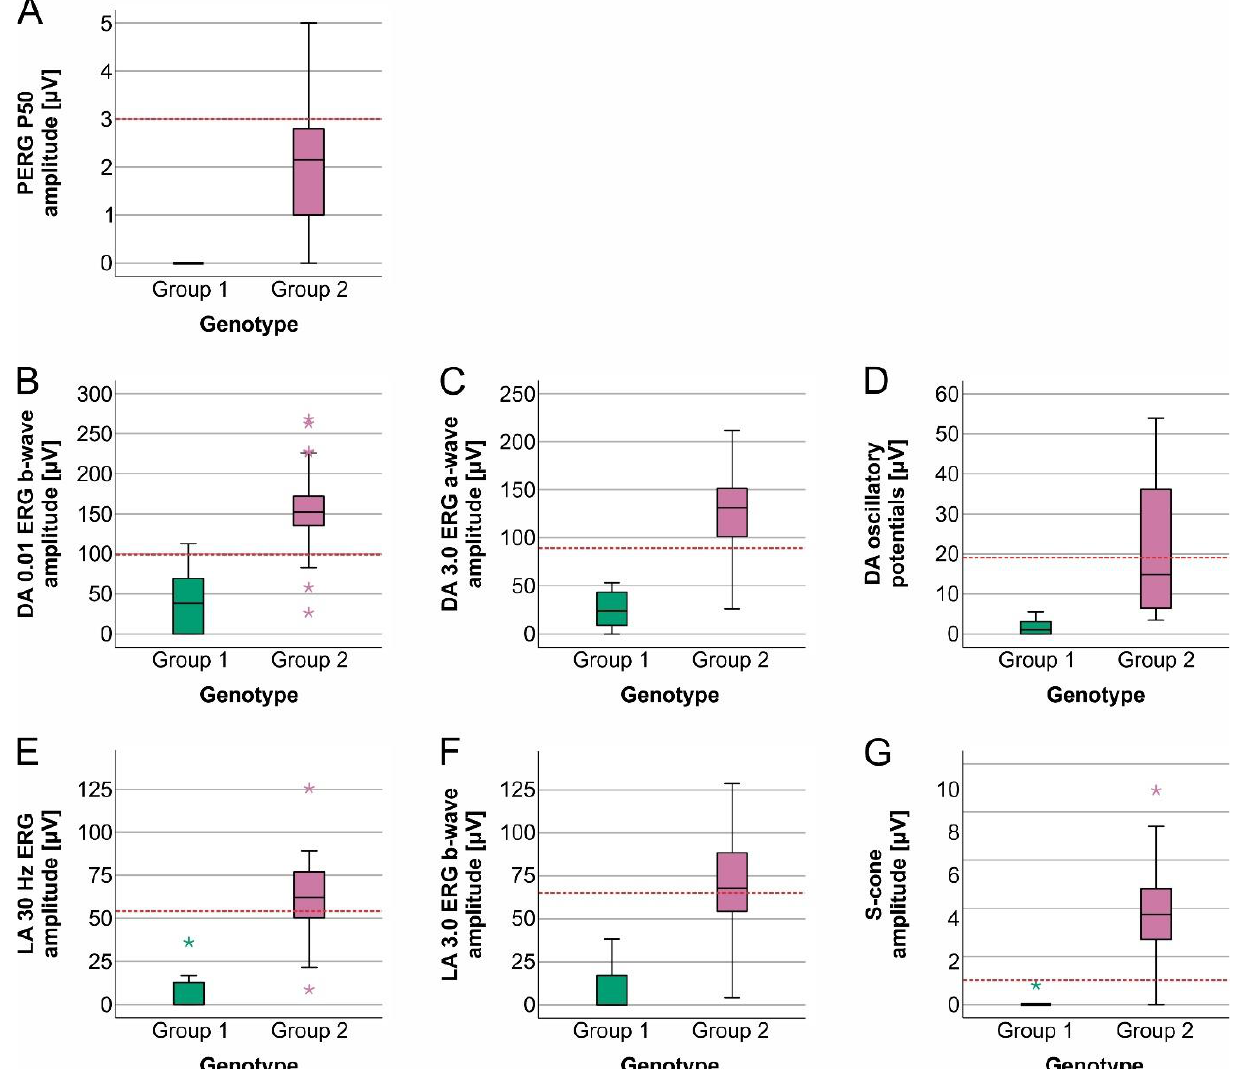
Figure 2. Boxplot charts showing various ERG parameters ’ amplitudes in patients with different genotypes. Group 1 patients had significantly lower PERG P50 amplitudes, DA 0.01 ERG b − wave amplitudes, DA 3.0 ERG a − wave amplitudes, oscillatory potentials, LA 30 Hz ERG amplitudes, LA 3.0 ERG b − wave amplitudes, and S − cone ERG amplitudes than Group 2 patients. Note that even though Group 1 patients were of the same age or even younger than Group 2 patients, all their ERG responses were significantly worse. Values were considered abnormal if they fell outside our laboratory normal range (marked with the red, dashed line). Horizontal lines represent median values, boxes represent half of the patients, and whiskers represent the remaining data except in the case of the outliers (stars).